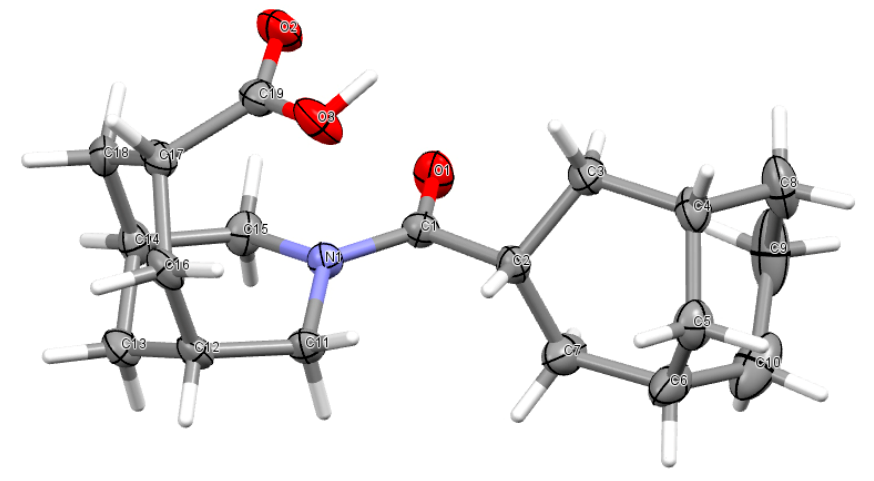
Figure 3. Molecular structure of 13 (ellipsoids are drawn at the 50% probability level).